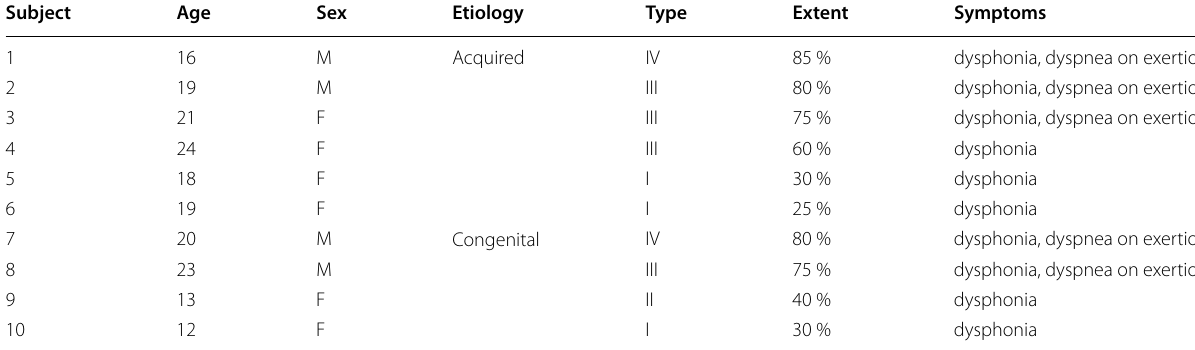
Illustrated subjects’ information as regard age, gender, clinical presentations, etiology of the laryngeal web and the percentage of glottis involved by the web. Types of the web: type I; the web involves less than 35% of the glottis, type II; from 35‑50%, type III; from 50‑75%, type IV; from 75‑90%, type V; more than 90% of the glottis (Cohen’s classification [20]). M: male, F: